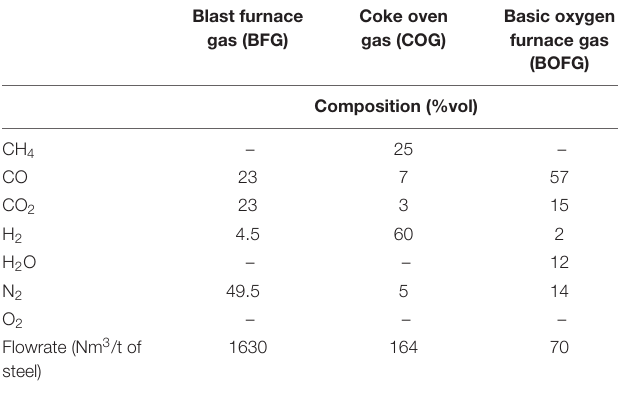
TABLE 1 | Composition of the steel mill off-gases used for the calculations (Santos,